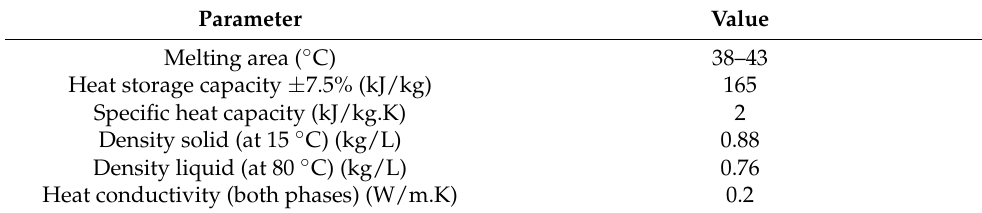
Table 2. The important properties of the PCM [52].